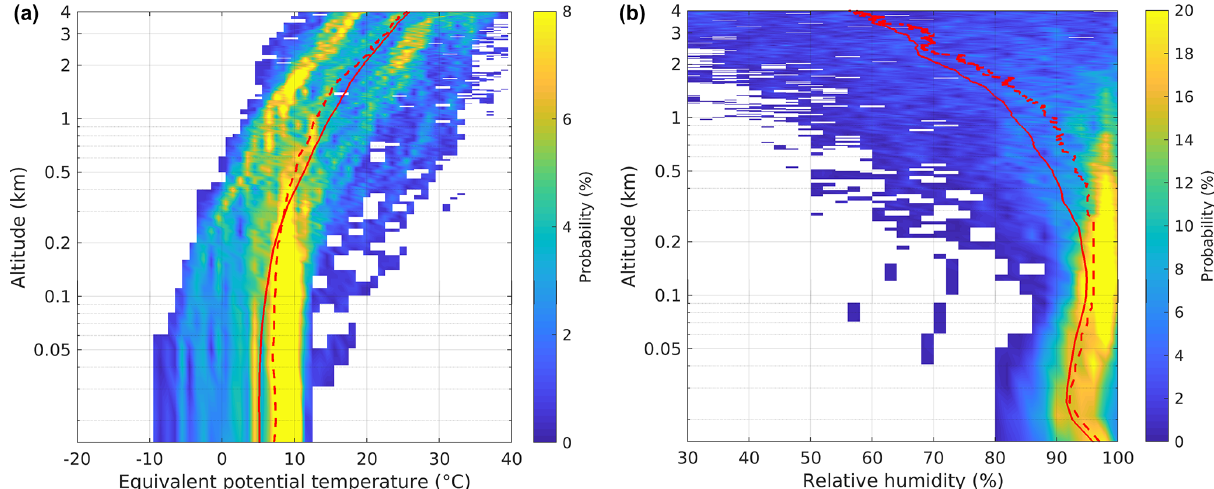
Figure 8. Probability of (a) equivalent potential temperature and (b) RHw as a function of altitude. Note that the probability is calculated for each height; hence, for each layer the probability sums to 100%. The solid red line shows the mean, and the dashed red line the median profile.